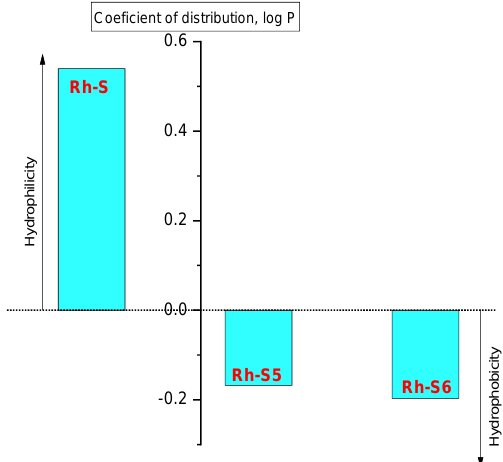
Figure 3. Logarithmic values of the partition coefficient (log P) of the investigated compounds: Rh- S, Rh-S5, and Rh-S6.